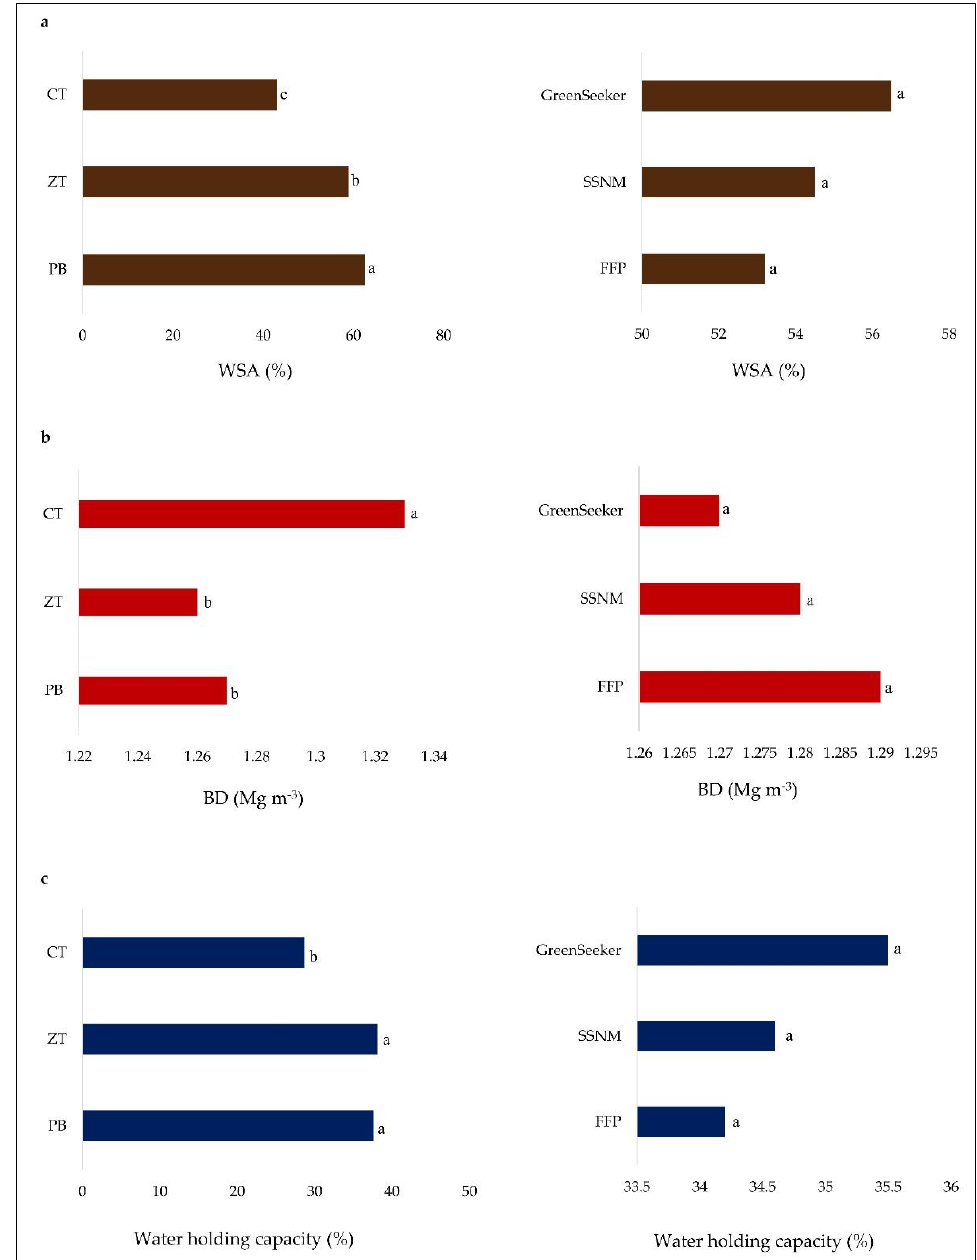
Figure 2. ( a ) Water soluble aggregates (WSA); ( b ) Bulk density (BD); ( c ) Water holding capacity under different tillage and nutrient management options [same letters after bars represent no statistical difference ( p ≤ 0.05); CT, ZT, and PB denote conventional tillage, zero tillage/direct seeding, and permanent bed, respectively; SSNM, and FFP denote site-specific nutrient management using Nutrient Expert Software, and farmers’ practice, respectively] .